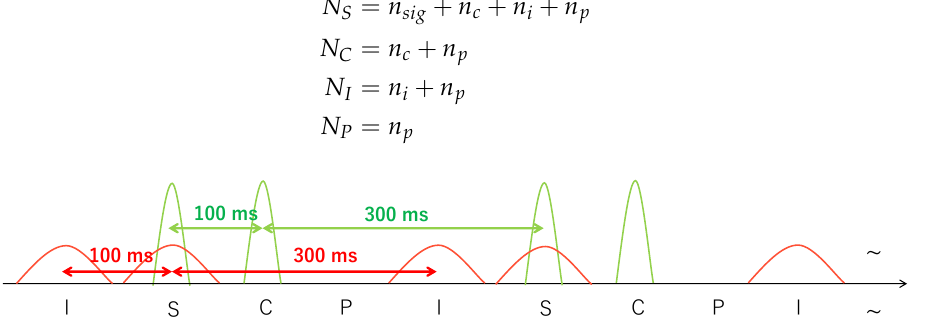
Figure 6. Four patterns of the beam combination between the two laser pulses where the green and red pulses are respectively creation and inducing laser pulses. The classifications are: S for two laser pulses, C for only the creation laser pulses, I for only the inducing laser pulses, and P for pedestals without laser